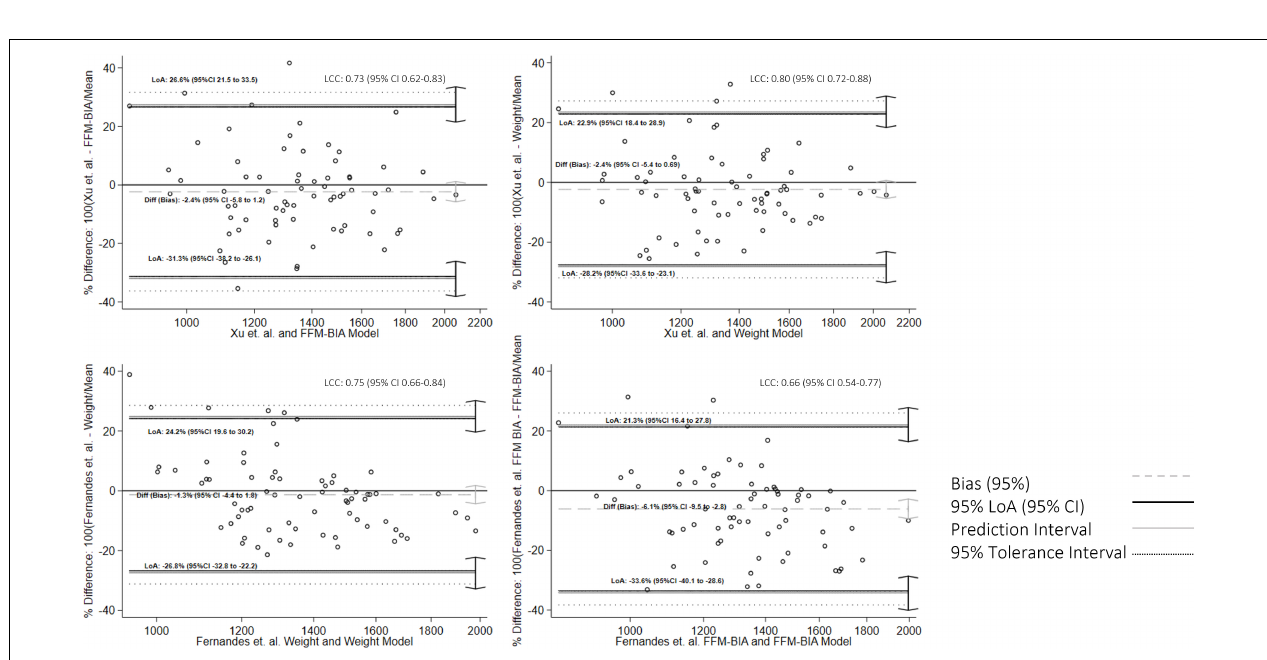
FIGURE 4 | Bland-Altman graph for concordance analysis between fitted values and predictions from previously validated equations.